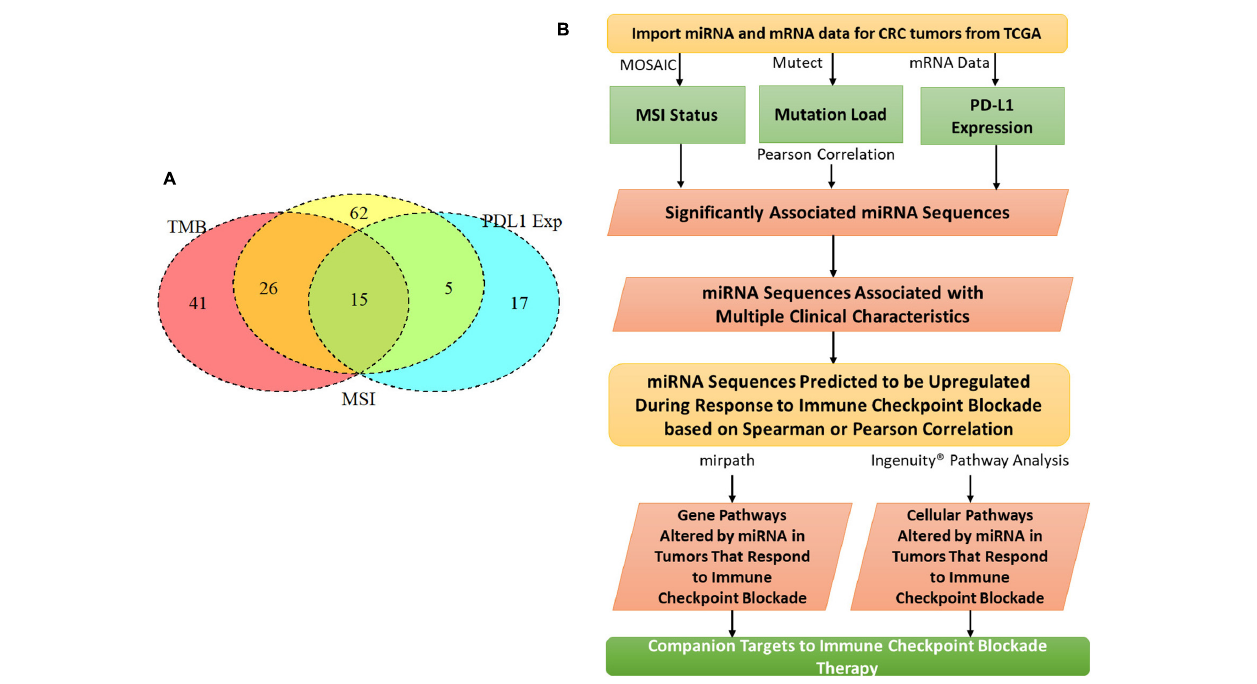
FIGURE 1 | MiRNAs correlated with clinical features related to immunotherapy. (A) Tumor mutation burden, programmed death ligand 1 expression, CD8 fraction, and microsatellite instability were analyzed for a cohort of 549 colorectal cancer patients in The Cancer Genome Atlas. 15 miRNAs were identified that correlated with all 3 clinical features. (B) The whole analysis pipeline of the whole project.